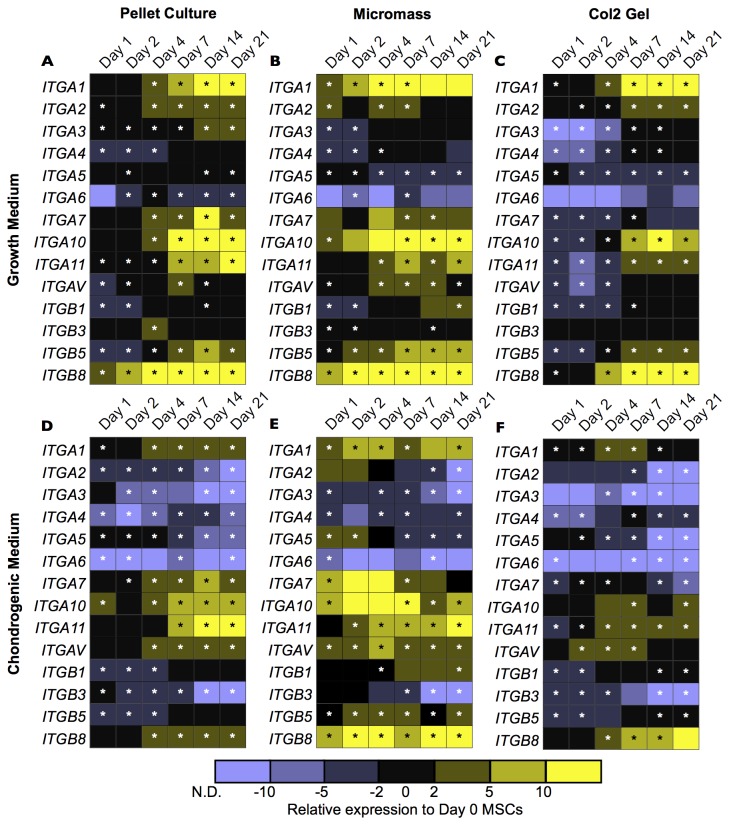
Quantitative PCR established mRNA expression of integrin subunits in hMSCs cultured in three different chondrogenesis models (pellet culture, micromass culture, or a type II collagen hydrogel) in either growth or chondrogenic medium over a time-course of 21 days.In general, integrin mRNA was down-regulated in chondrogenic medium and there were similar expression patterns between the different chondrogenesis conditions. Each square represents mean expression relative to GAPDH and to day 0 hMSCs on tissue culture plastic in growth medium of N=3 independent experiments performed in technical triplicate. Down-regulation is represented in purple (N.D.: not detected) and up-regulation is represented in yellow. Statistically significant changes (p < 0.05) compared to day 0 are denoted by an asterisk (*). Line charts depicting the means and range of values are in the Figures S2-S8, and statistical significance is in Figures S12-S14.